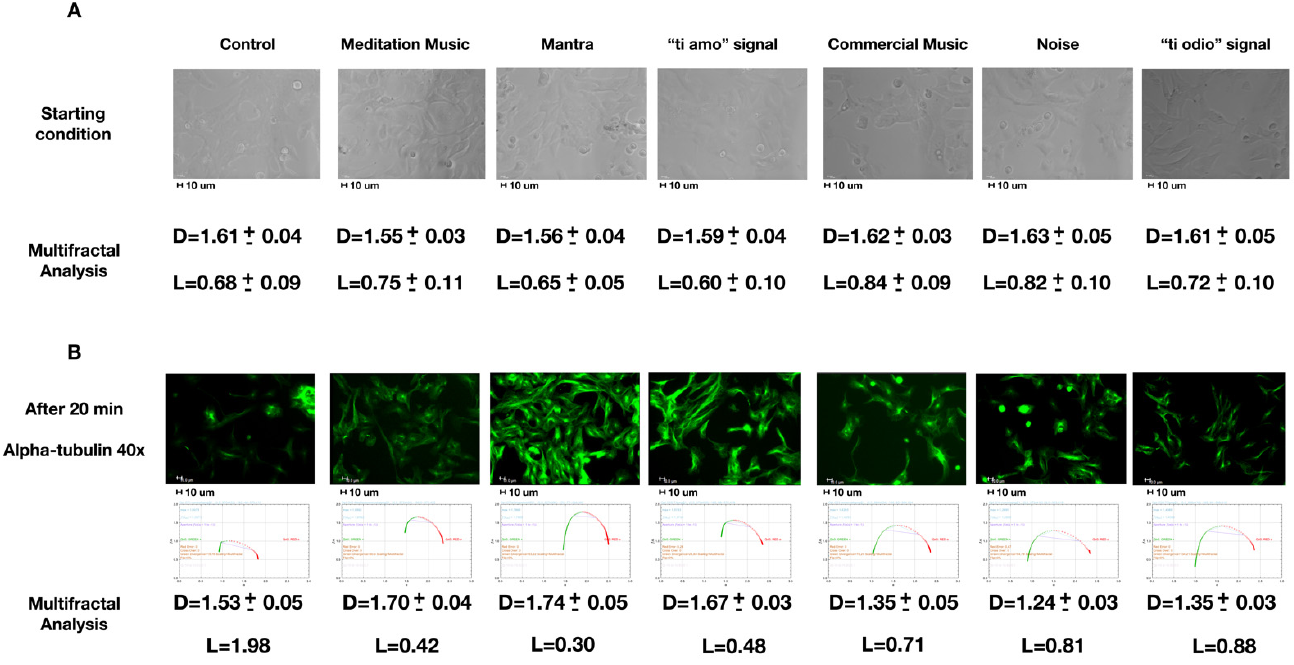
Figure 1. ( A ) Starting condition, description in the text. ( B ) Alpha-tubulin staining after the different 20-min sounds stimulation with a graph below representing ƒ( α ) vs. α (the typical pattern for multifractals) and the results of the multifractal analysis reporting the average fractal dimension (D) and lacunarity (L). In ( B ), all L parameters vary less than ± 0.002. All the photos are representative images selected from 5 positions and 6 experimental repetitions. Images were acquired with 40×/0.60 dry objective. Scale bar 10 μ m.